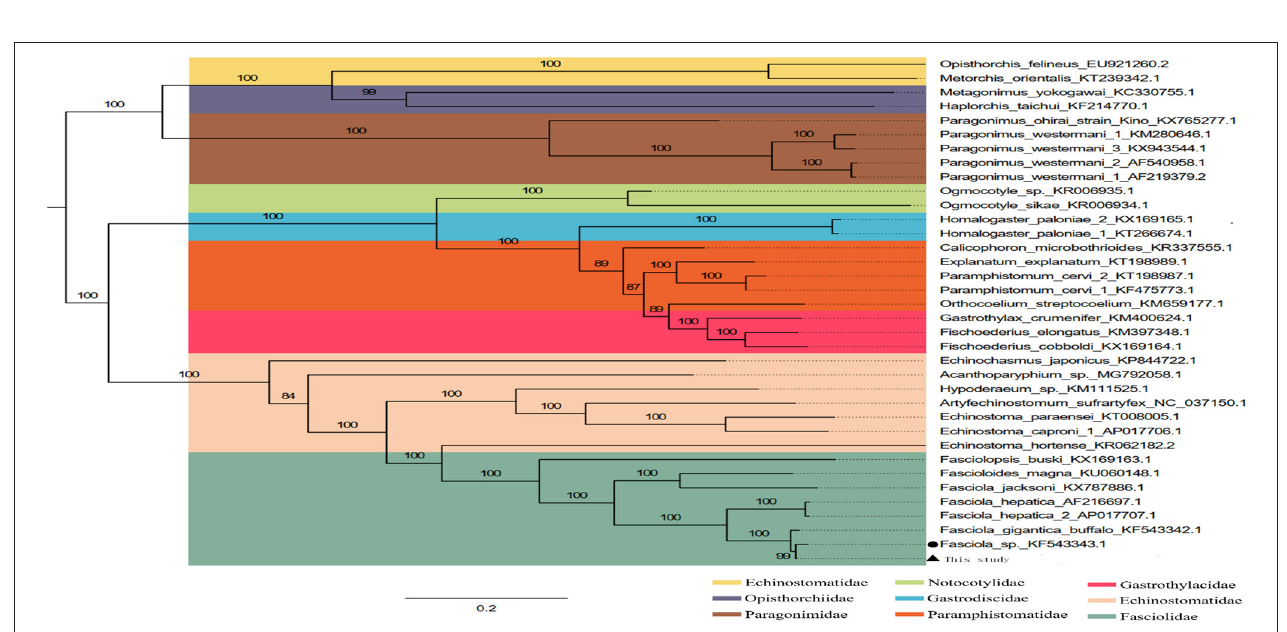
FIGURE 4 | Inferred phylogenetic relationship among the F. intermediate. The phylogenetic tree was inferred from the nucleotide sequences of mitogenome by using ML methods (Numbers on branches indicate ML).